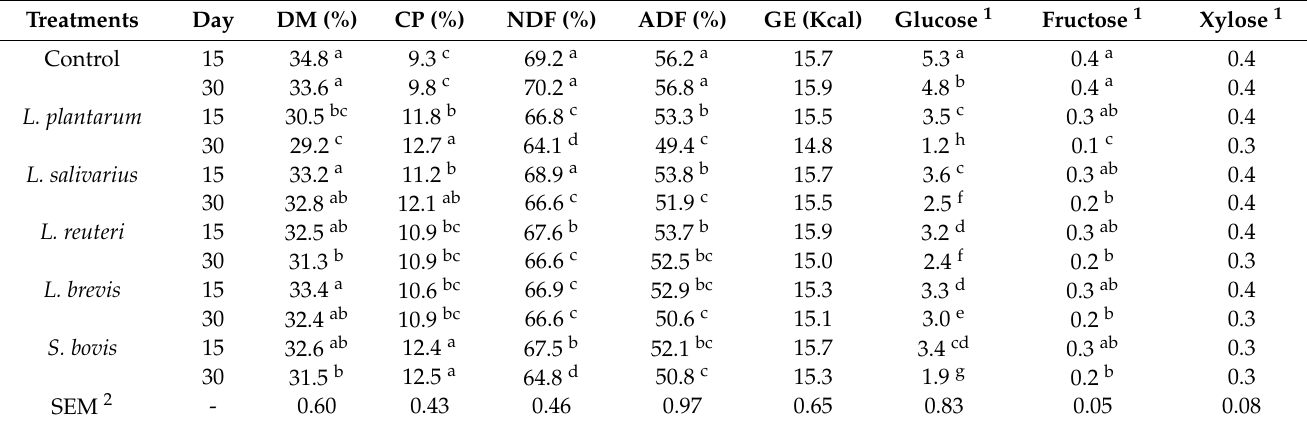
Table 3. Effect of inoculation of LAB on the chemical composition of ensiled rice straw (DM basis). Treatments